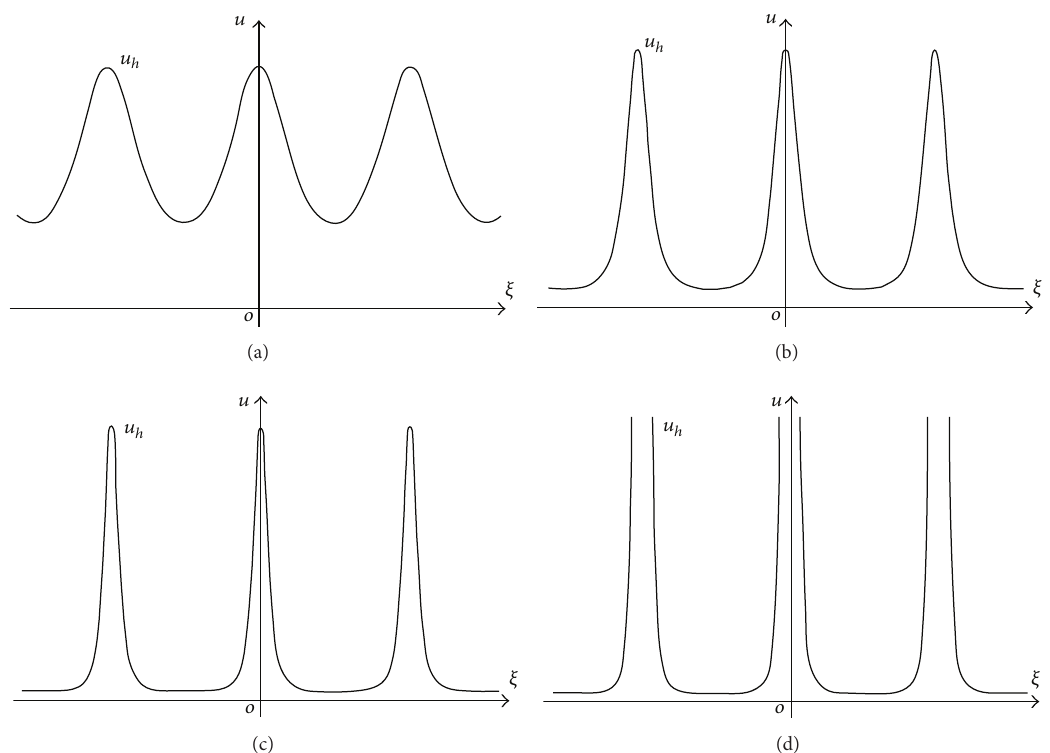
Figure 18: (The periodic blow-up wave is bifurcated from the periodic wave). The varying process for the graph of 𝑢 ℎ when 𝑐 > 0 , 𝛿 < 0 , 𝑎 > 0 , 𝜂 > 0 , and 𝑏 → 0 − 0 , where 𝑐 = 1 , 𝛿 = −1 , 𝑎 = 1 , 𝜂 = 1.57 , and (a) 𝑏 = 0 − 0.2 . (b) 𝑏 = 0 − 0.1 . (c) 𝑏 = 0 − 0.05 . (d) 𝑏 = 0 − 0.01